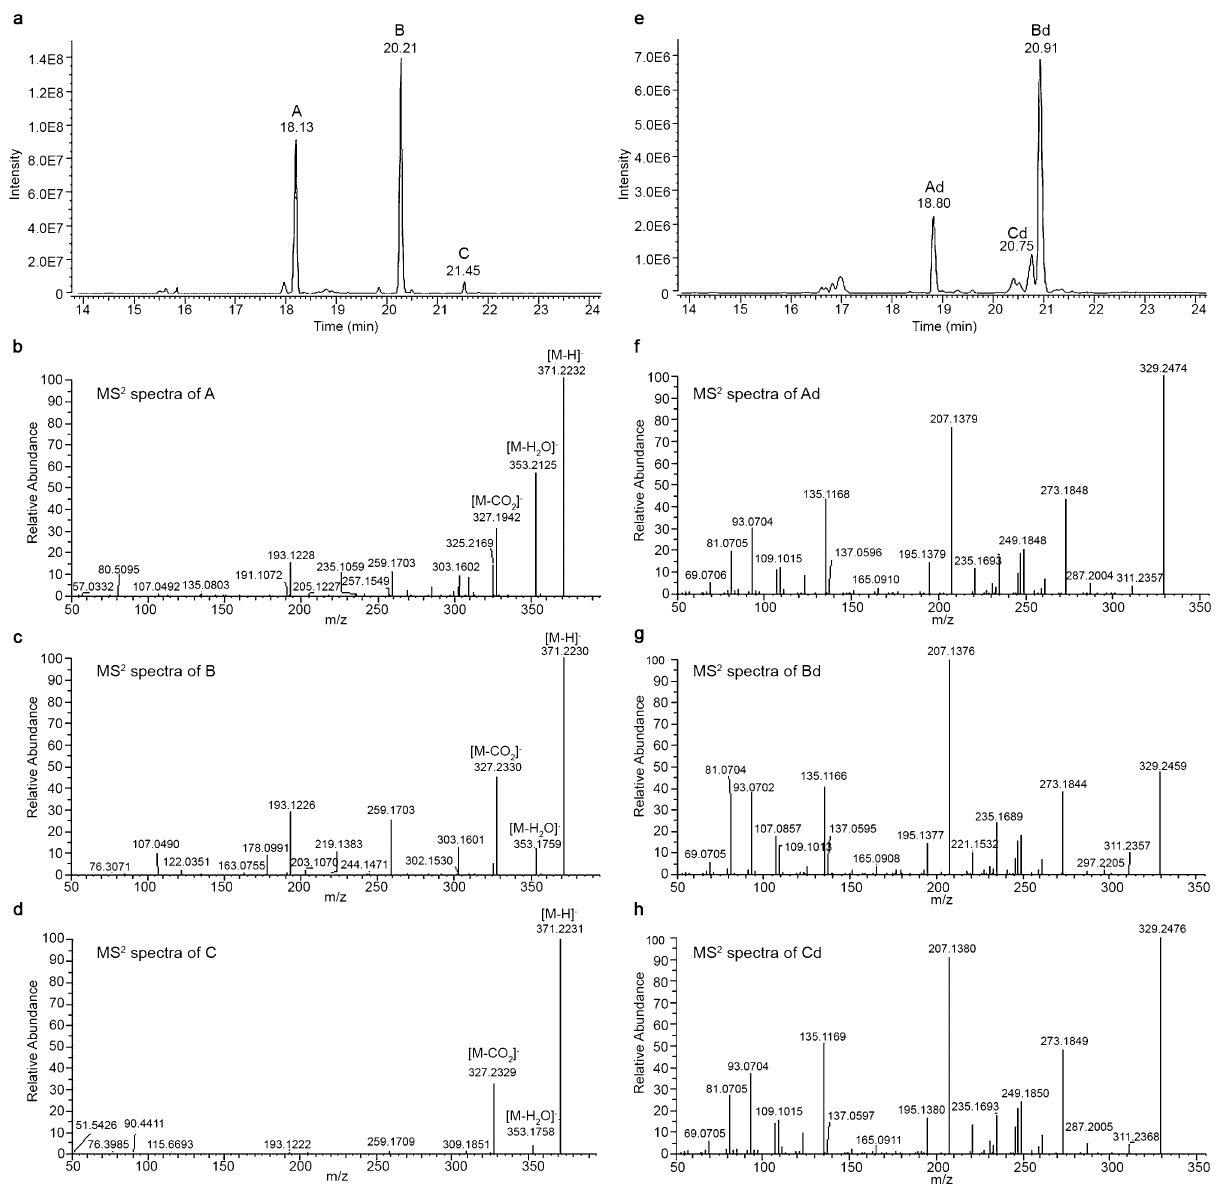
relative fragmentation spectra, in negative ionization mode, for the identified peaks A (panel B ), B (panel C ) and C (panel D ). ( E ) UHPLC-HRMS extracted ion chromatogram (EIC) for molecular formula C 22 H 31 O 2 in decarboxylated FM2 and the relative fragmentation spectra, in negative ionization mode, for the identified peaks Ad (panel F ), Bd (panel G ) and Cd (panel H